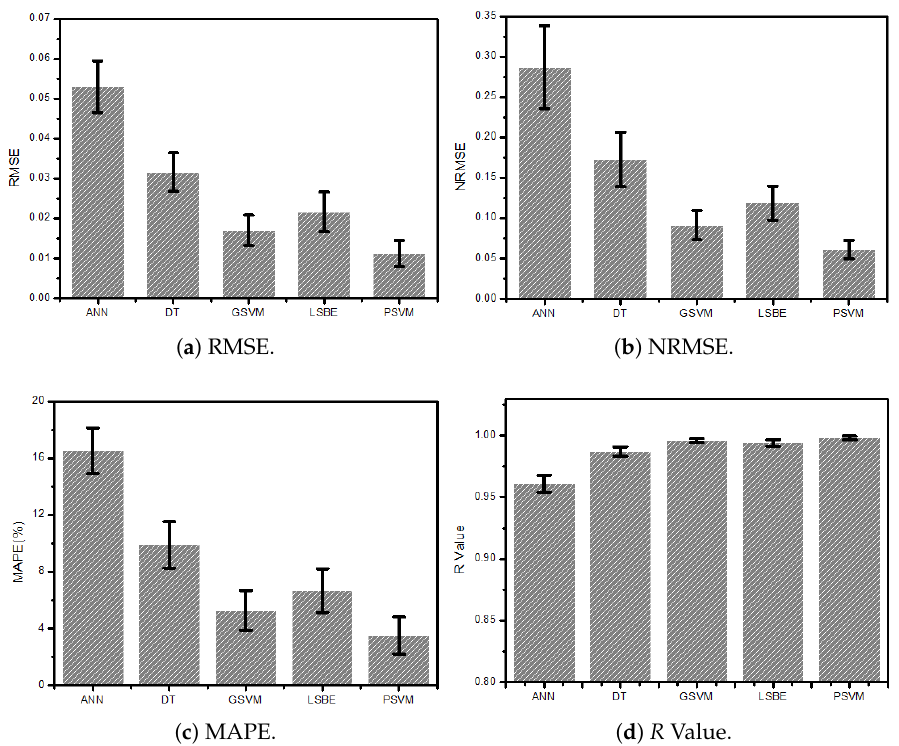
Figure 7. Comparison of different machine learning algorithms for surface resistance: ( a ) RMSE, ( b ) NRMSE, ( c ) MAPE, ( d ) R Value.